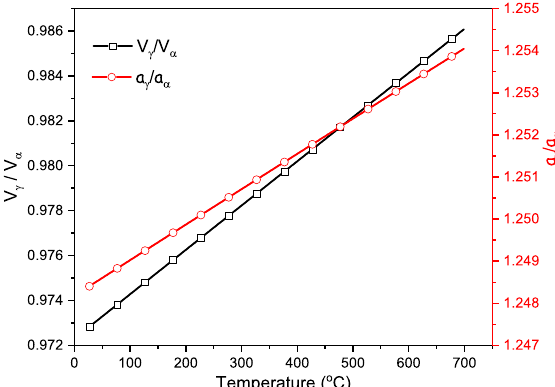
Figure 7. Ratio of volume and lattice parameter in gamma and alpha phase as a function of